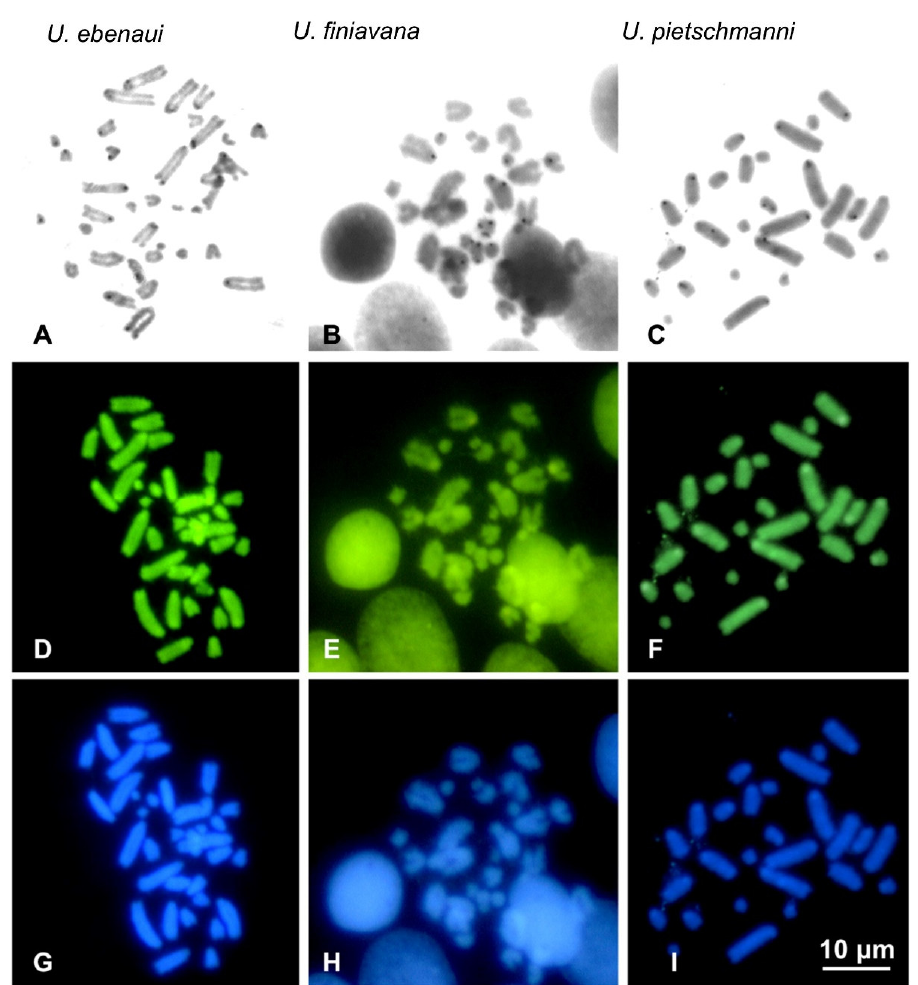
Figure 2. Metaphase plates of U. ebenaui ( A , D , G ), U. finiavana ( B , E , H ) and U. pietschmanni ( C , F , I ) sequentially stained with C-banding + Giemsa ( A – D ) + CMA 3 ( D – F ) + DAPI ( G – I ).